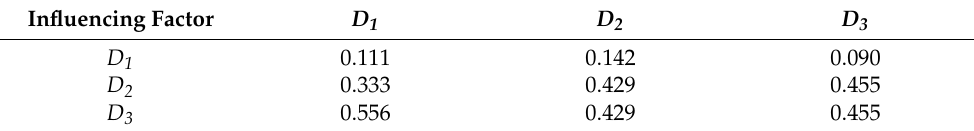
Table 7. Standardised values.